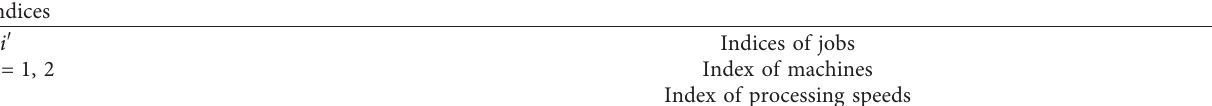
Table 1: The notation used to formulate the